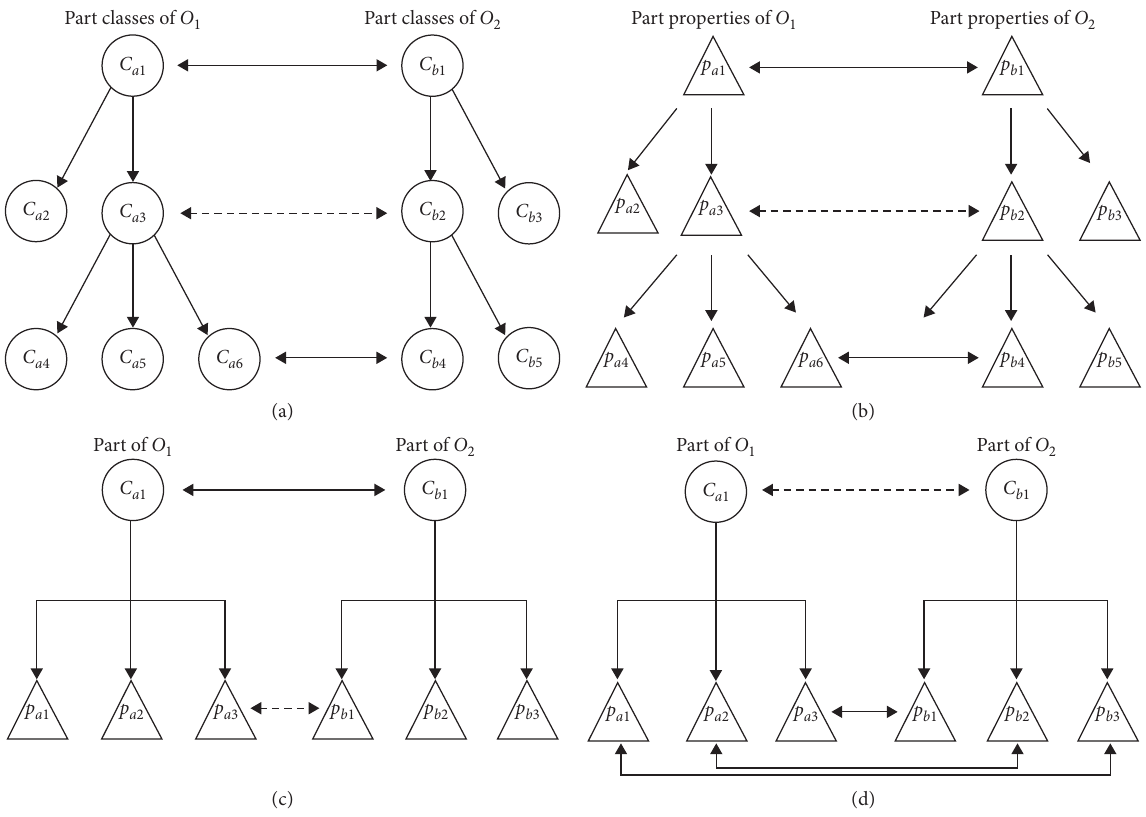
Figure 3: MRCP taxonomy-based